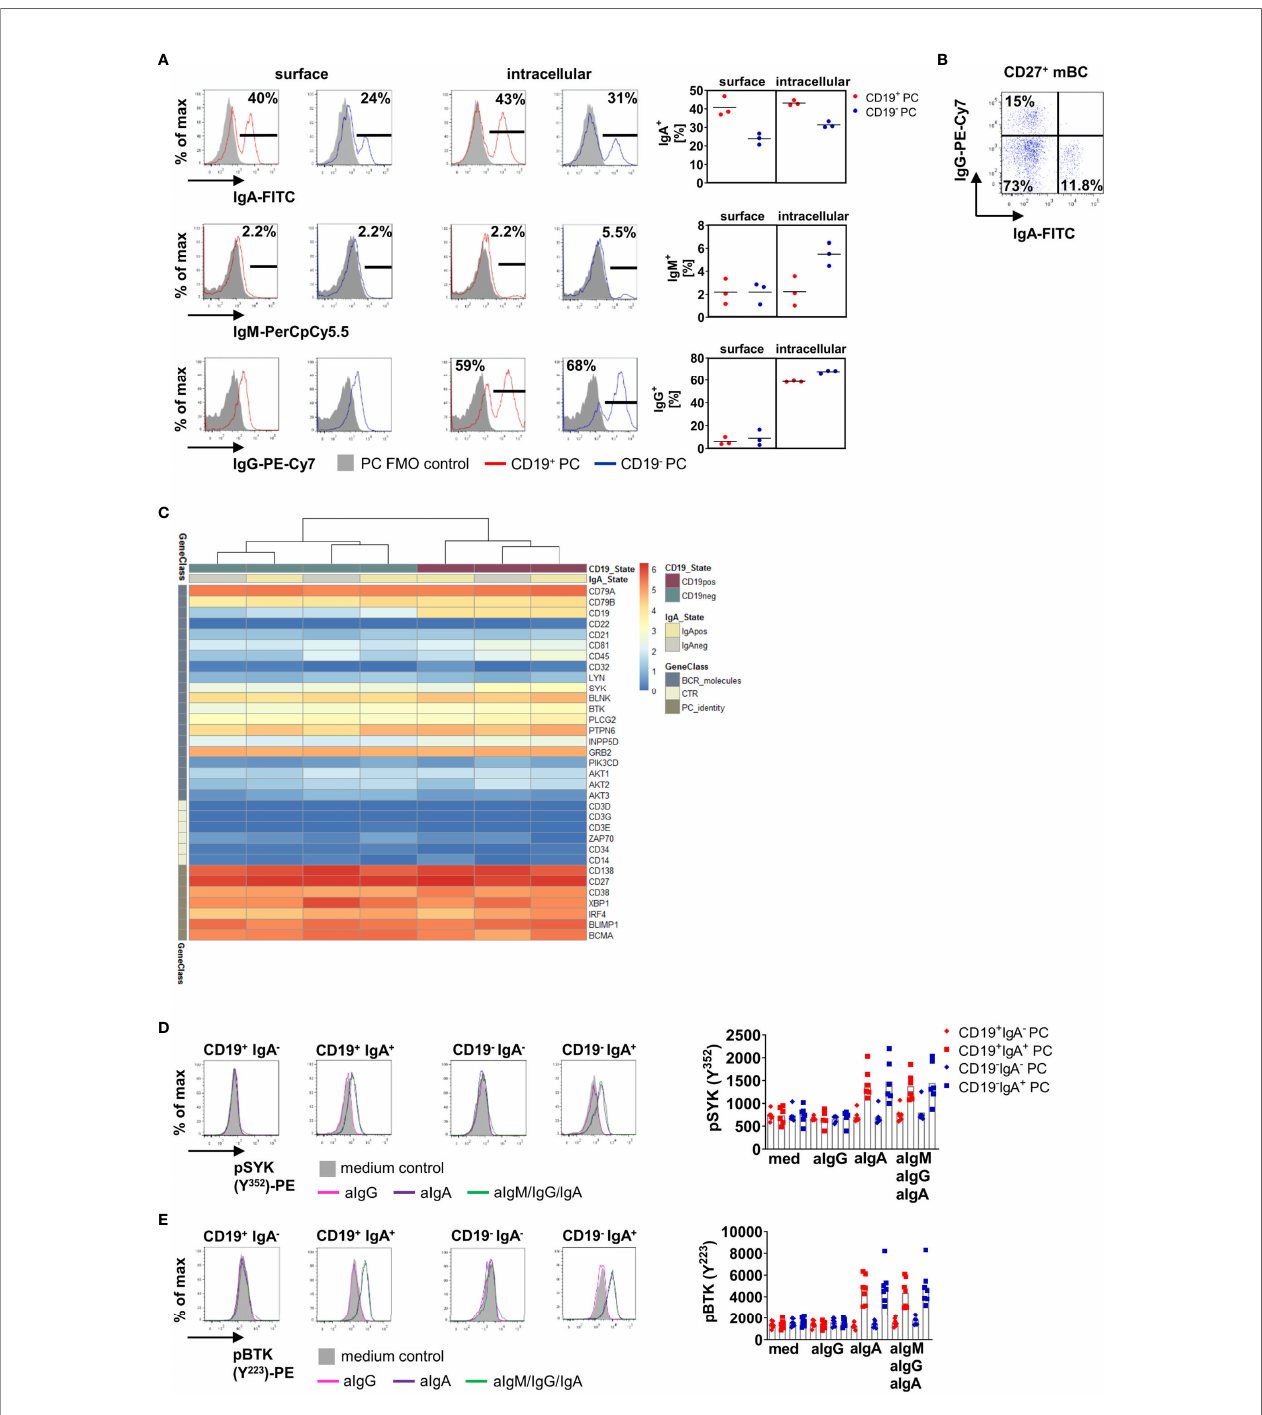
FIGURE 3 | IgA + BMPC are responsible for enhanced phosphorylation of PTKs after BCR stimulation. (A) Surface and intracellular staining of IgA, IgM and IgG in BMPC. Representative histograms of one out of three experiments (left), bar indicates gate for Ig + cells. Filled grey histograms indicate the PC FMO control, the solid line indicates staining of Ig. Numbers indicate mean of the frequency of Ig + among each subset (n = 3). Frequencies for surface and intracellular Ig expression from three experiments (right), bar indicates mean. (B) IgA and IgG surface staining of CD27 + CD38 − memory BMBC. (C) mRNA expression for BCR associated genes in CD19 + IgA + , CD19 + IgA − , CD19 − IgA + and CD19 − IgA − BMPC shown by log 2 (CPM+1) values. n = 2. (D, E) BM MNCs were either stimulated with 10 µg/ml anti-IgA F (ab) 2 (aIgA), 10 µg/ml anti-IgG F(ab) 2 (aIgG) or 30 µg/ml anti-BCR F(ab) 2 IgM/IgG/IgA (aIgM/IgG/IgA) for 5 min and stained for pSYK (Y 352 ) ( D, n = 5 – 6) or pBTK (Y 223 ) ( E, n = 7). A representative histogram is shown for each subset (solid lines: 5 ′ anti-BCR; fi lled grey histogram: 5 ′ RPMI). Signi fi cance was tested with Friedman- Test with Dunn ’ s correction for multiple